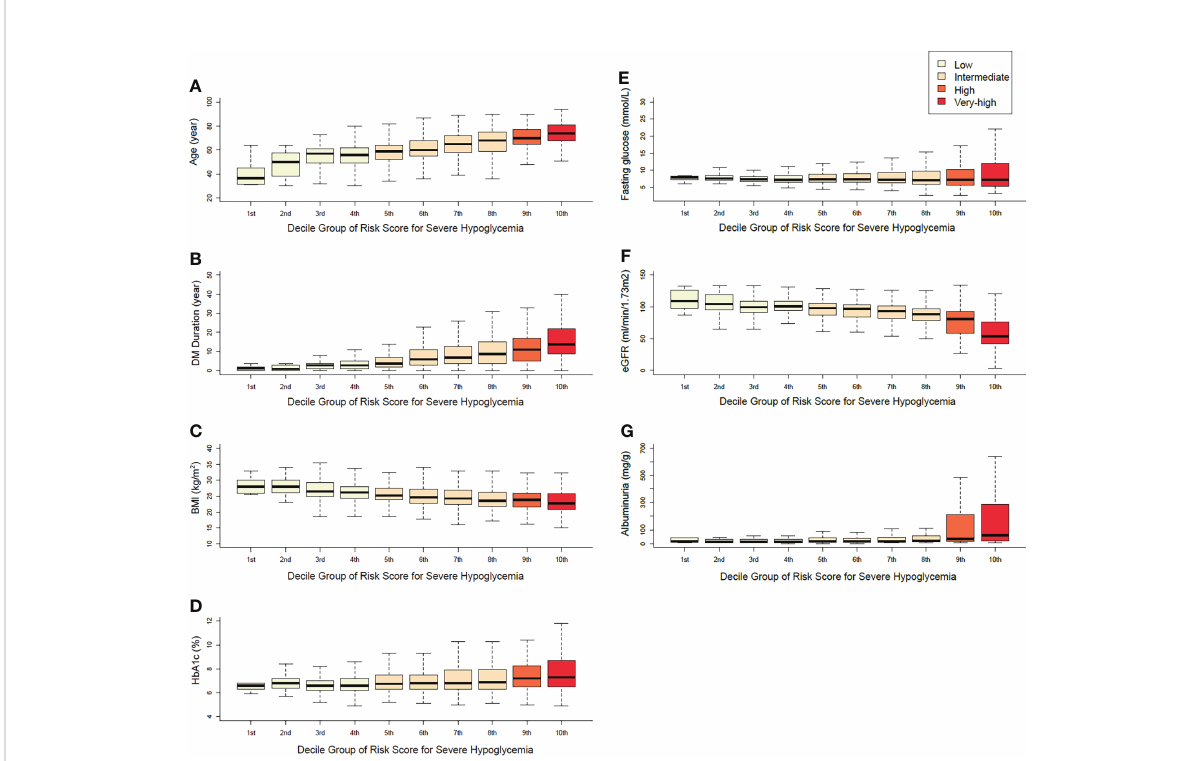
FIGURE 2 Distributions of the main variables in each decile group (A) age, (B) duration of diabetes, (C) body mass index, (D) HbA1c, (E) fasting plasma glucose, (F) eGFR, (G)